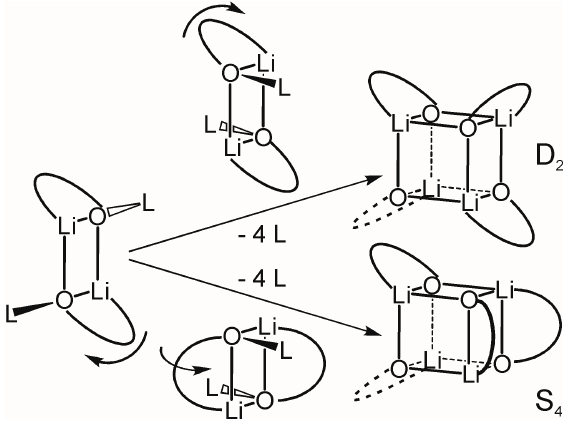
Scheme 3. Dimerization paths of the transoid rings of 2 to achieve the known limiting cubane geometries with D 2 or S 4 symmetry. Note that 3b – d all adopt the D 2 geometry.